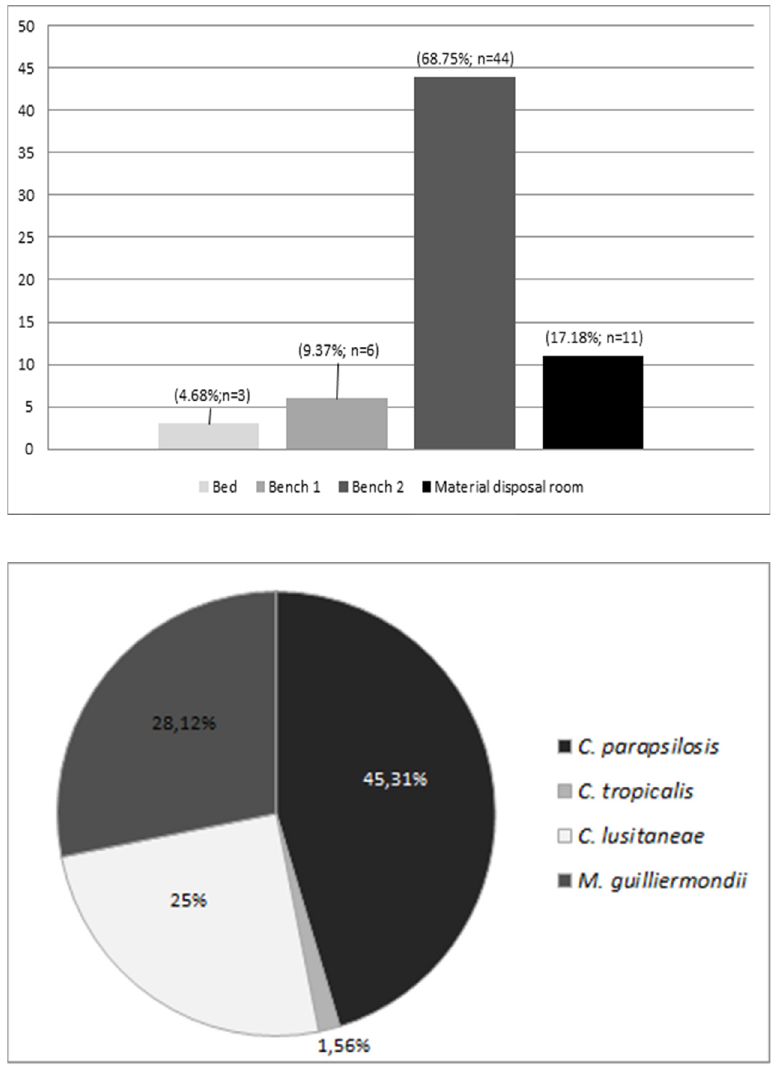
Figure 1. Distribution of the number of yeasts isolates according to the location of the surfaces located in the ICU of the hospital located in the city of Pelotas RS.